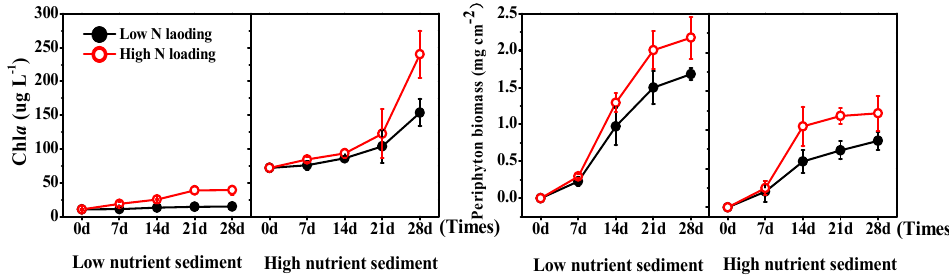
Figure 2. Time series of chlorophyll a (Chl a ) concentrations and periphyton biomass in different treatments during the experiment. Factors are sediment type and external nitrogen loading. Solid circle: low N loading; empty circle: high N loading. Values are mean ± SD, n = 4, and the bars show standard deviation.